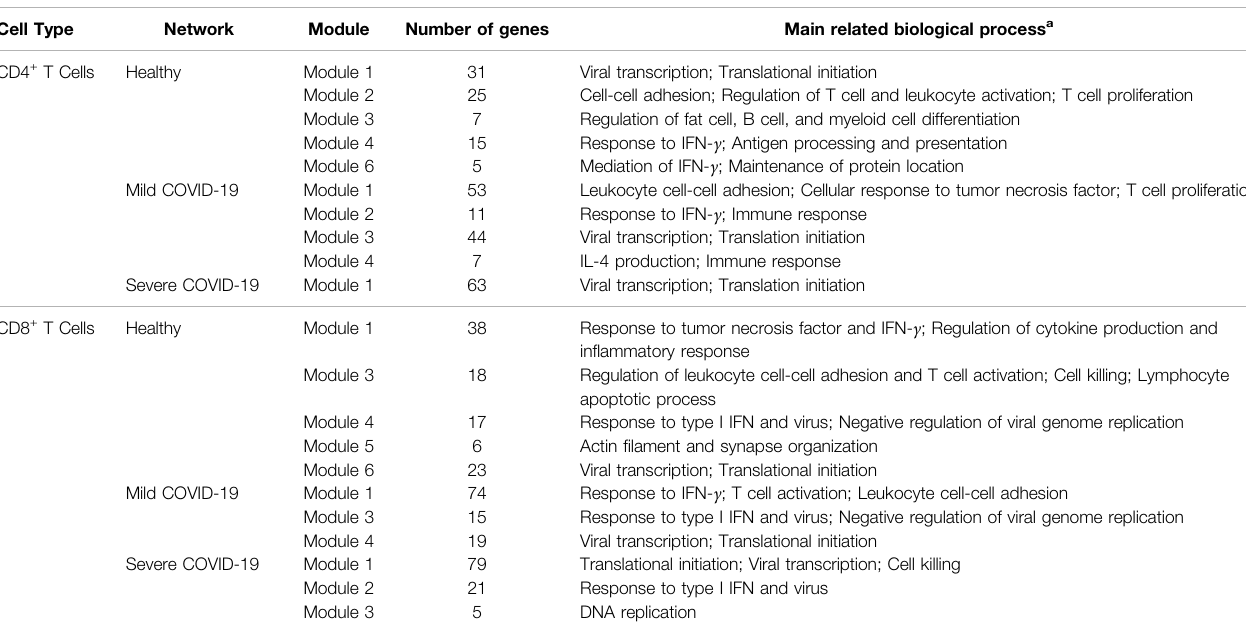
TABLE 3 | The main related GO biological process of each module of each